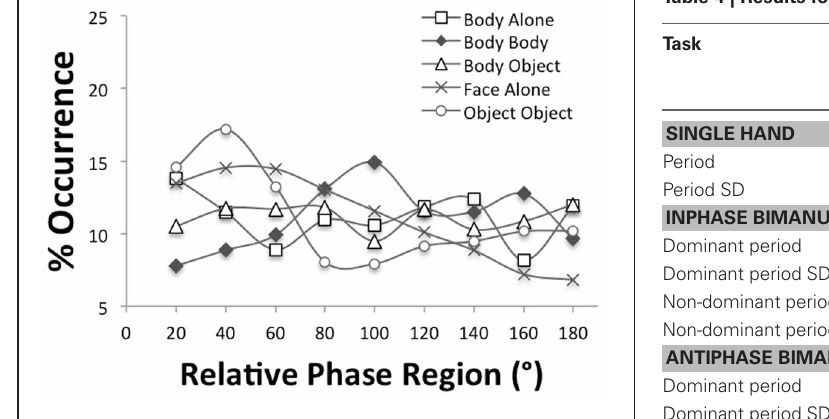
FIGURE 3 | Distributions of relative phase for the five synchronization tasks.